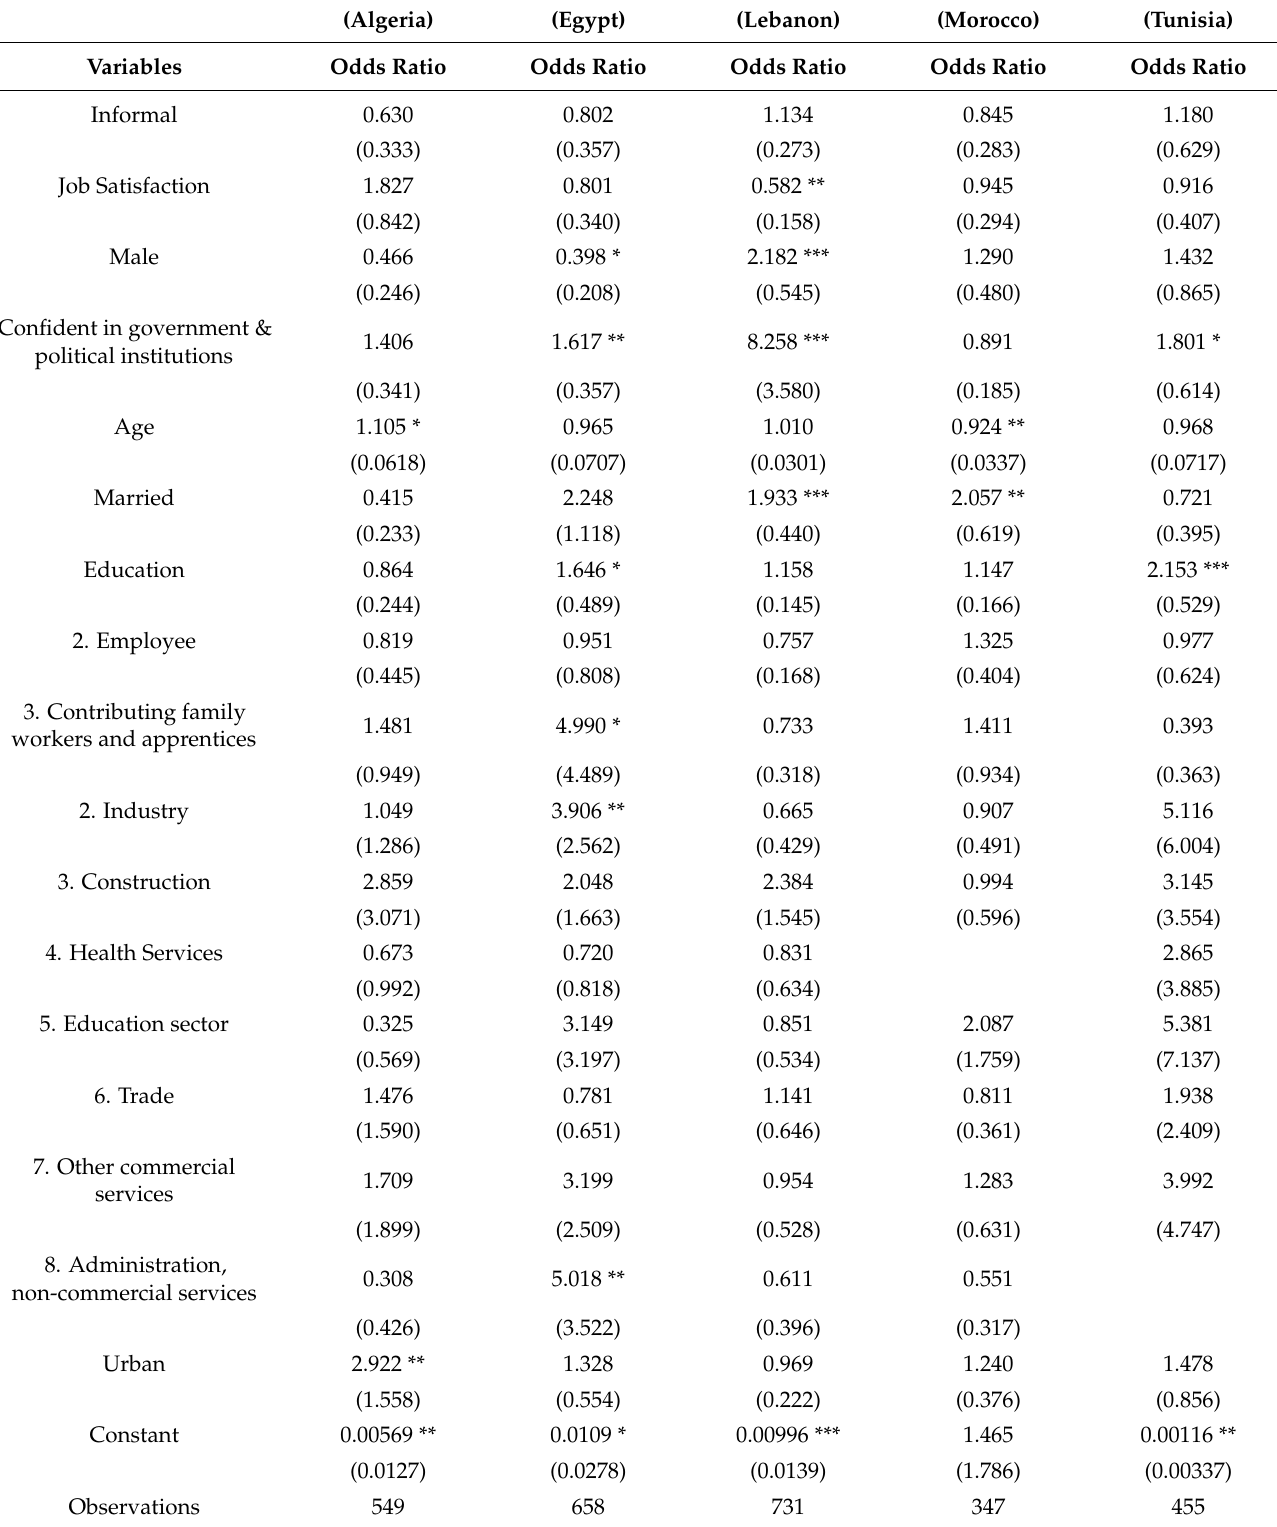
Table A3. Logistic regression on the involvement index by